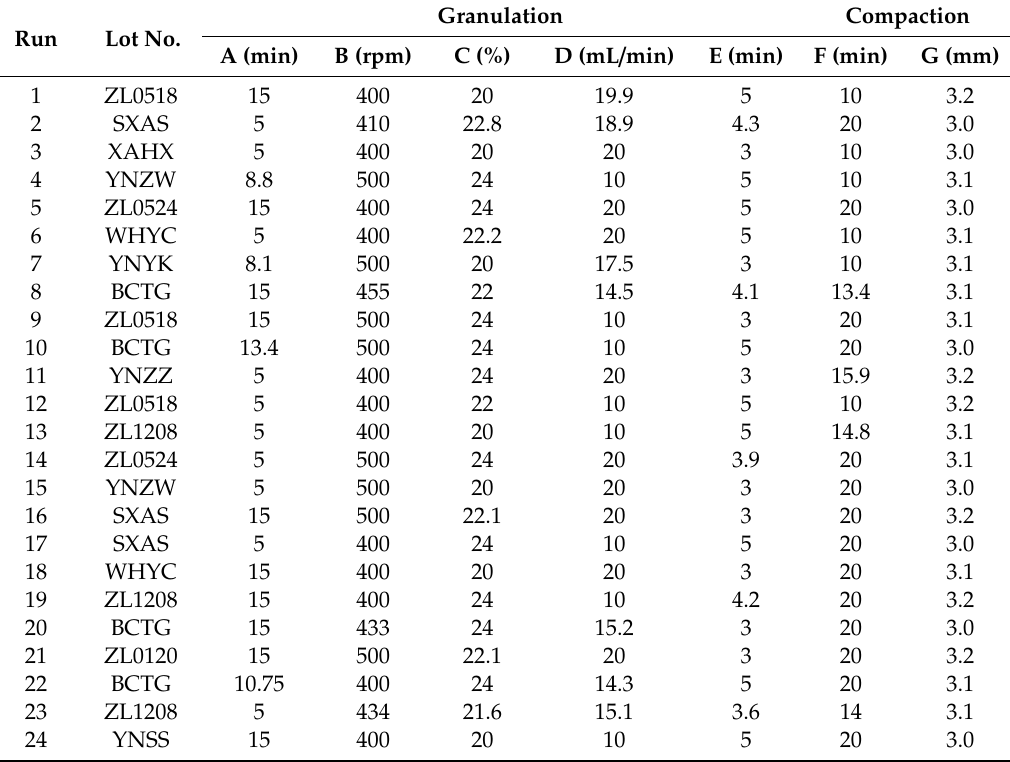
Table 2. D-optimal design for the Panax Notoginseng Saponins immediate release tablet (PNS) IRT production process with di ff erent lots of PNS